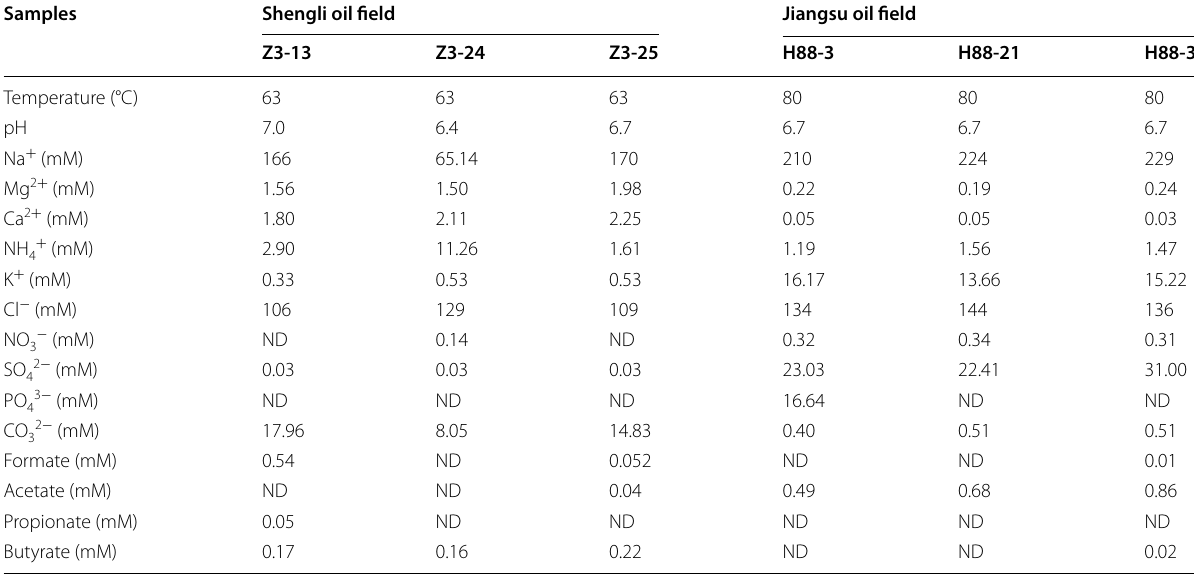
ND, not detected. The detection limit of formate and PO 4 3 − is 1